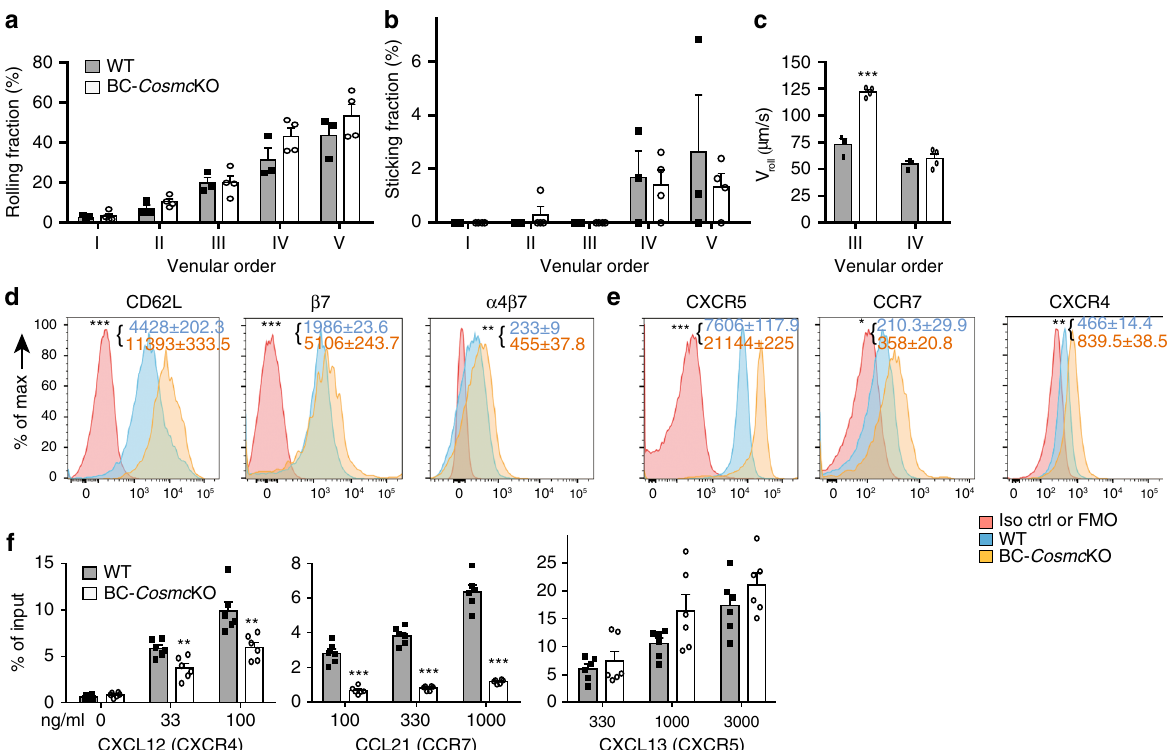
Fig. 5 Intravital microscopy of Cosmc -de fi cient B cells. a – c For IVM, puri fi ed B cells from WT and BC- Cosmc KO mice were labeled with calcein and injected into the left femoral artery catheter of the inguinal lymph node. Data from three independent experiments ( n = 3) were analyzed using two-way analysis of variance (ANOVA) and presented as mean ± SEM, *** denoting p < 0.001. a Rolling fraction was measured as the percentage of rolling cells in the total fl ux of cells in each HEV. p values for venular order I, II, III> 0.9999, p value for venular order IV = 0.2154, p value for venular order IV = 0.4488. b Sticking fraction was determined as the percentage of adherent cells in the total lymphocyte fl ux through each HEV. p values for venular order I, II, III, IV> 0.9999, p value for venular order V = 0.9682. c Rolling velocity of B cells that rolled in order III and IV was calculated and quanti fi ed. p values for venular order III< 0.0001, p values for venular order IV = 0.7957. d , e Surface expression levels of ( d ) lymphocyte homing-related molecules, and ( e ) chemokine receptors on splenic B cells of WT control and BC- Cosmc KO mice. Splenic B cells were stained with indicated antibodies or isotype matched antibodies. Representative histogram plots comparing molecule expressions by mean fl uorescence intensity (MFI) on B cells from both groups of mice. Histogram in pink: antibody isotype control or FMO, fl uorescence minus one control. Histogram in blue: WT and Histogram in yellow: BC- Cosmc KO. p values for CD62L, β 7, and α 4 β 7 in d are < 0.0001, 0.0002, and 0.0046. p values for CXCR5, CCR7, and CXCR4 in e are < 0.0001, 0.0154, and 0.0016. Data are presented as average ±SEM of each genotype and represent a representative experiment from three independent experiments ( n = 2 or 3 for WT and n = 3 for BC- Cosmc KO mice in each experiment) ( f ) Chemotaxis of Cosmc -de fi cient B220 + B cells compared with cells from littermate controls. Percentages of input cells that were found in lower well are shown. In the bar graphs on left side, p values for media only (0) is 0.0911, for 33ng/ml of CXCL12 is 0.0048, and for 100ng/ml of CXCL12 is 0.006. In the bar graphs in the middle, p values for all concentrations of CCL21 are < 0.0001. In the bar graphs on right side, p values for 330ng/ml of CXCL13 is 0.4864, and for 1000 ng/ml of CXCL13 is 0.0898, p value for 3000ng/ml of CXCL13 is 0.241. Data are presented as an average ±SD) of duplicate of each genotype and from three independent experiments ( n = 3). Each symbol (black square and open circle for WT and BC- Cosmc KO, respectively) represents an individual mouse. For d – f , unpaired two-tailed student ’ s t tests were performed to determine statistical signi fi cance with *** denoting p < 0.001, ** p < 0.01, * p < 0.05. Source data are provided as a Source Data fi